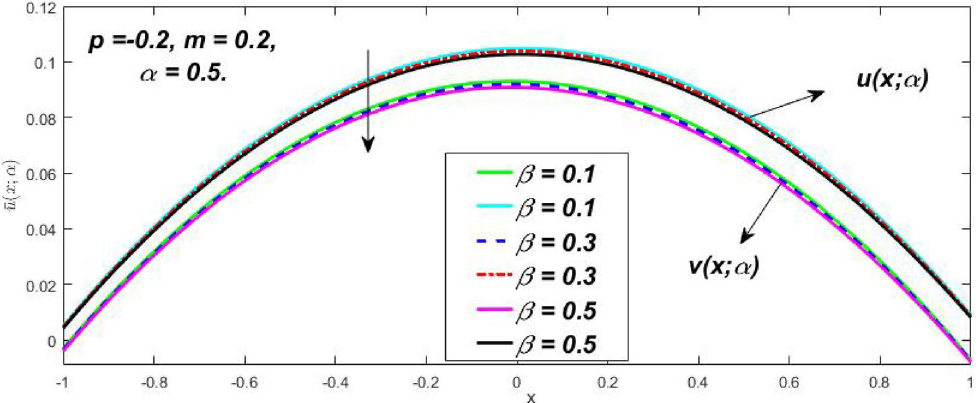
Figure 16. Fuzzy velocity profiles for the impact of β .